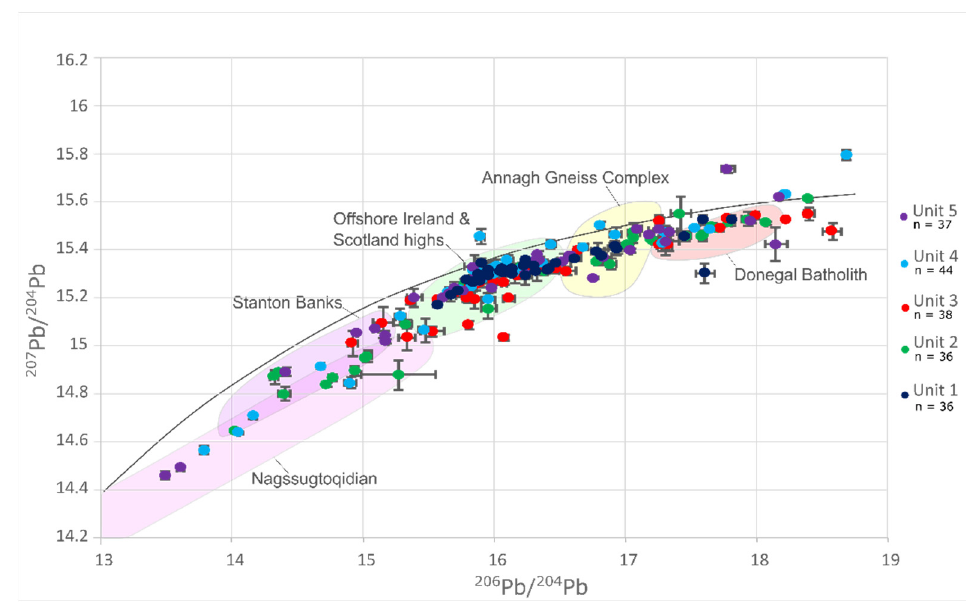
Figure 7. 206 Pb/ 204 Pb versus 207 Pb/ 204 Pb Pb-in-K-feldspar isotopic ratios for K-feldspars from the five channel sandstones in the Mullaghmore Sandstone Formation at Ballycastle (see channel key on right of plot). Pb evolution curve after Stacey and Kramers [97] indicated. Plotted error bars are 2 δ .